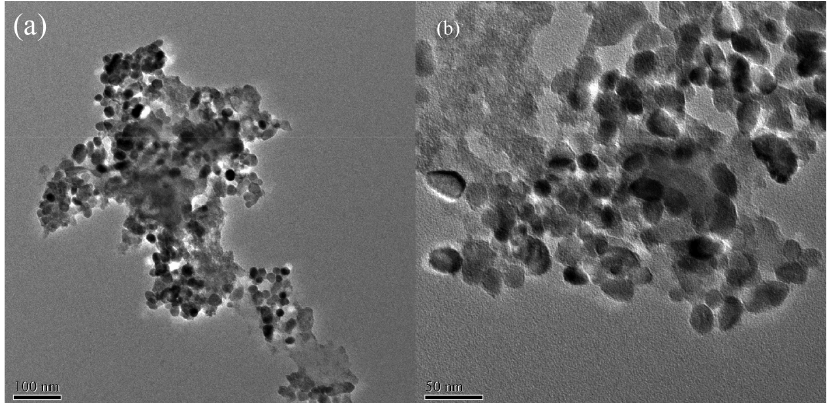
Figure 7: TEM images of Co 3 O 4